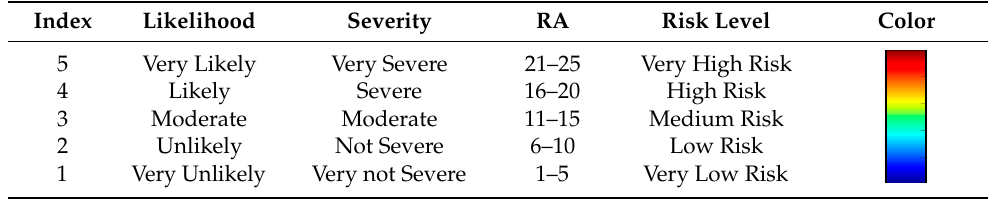
Figure 3. Risk matrix concept applied RA. Table 3. Risk level with likelihood and severity indices.